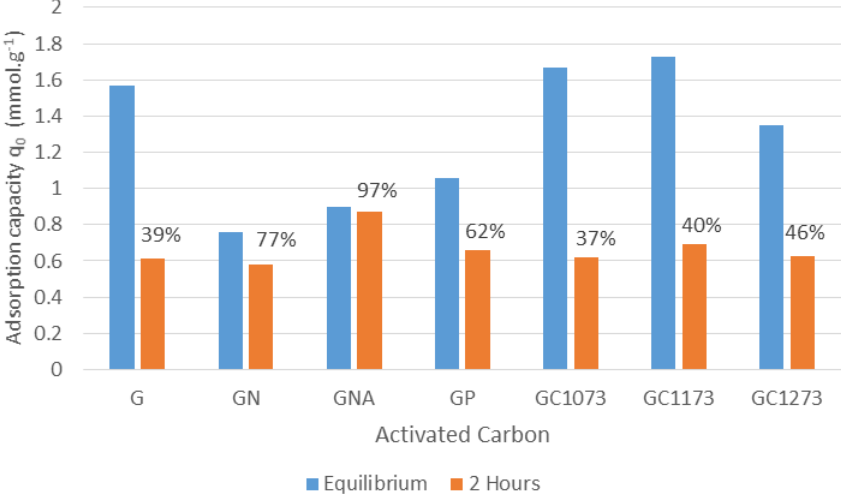
Figure 8. Comparison between the adsorption in the calorimeter until equilibrium was reached and the maximum capacity of adsorption Q o from the Langmuir model.